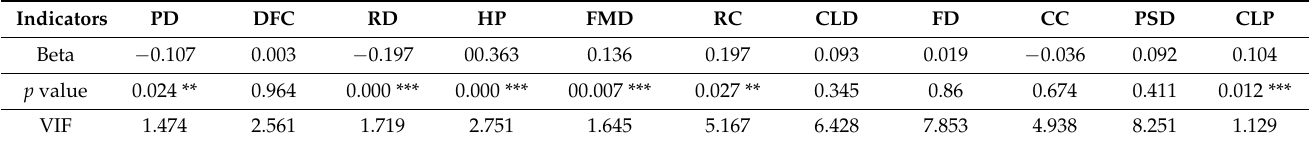
Table 4. Preliminary test results of